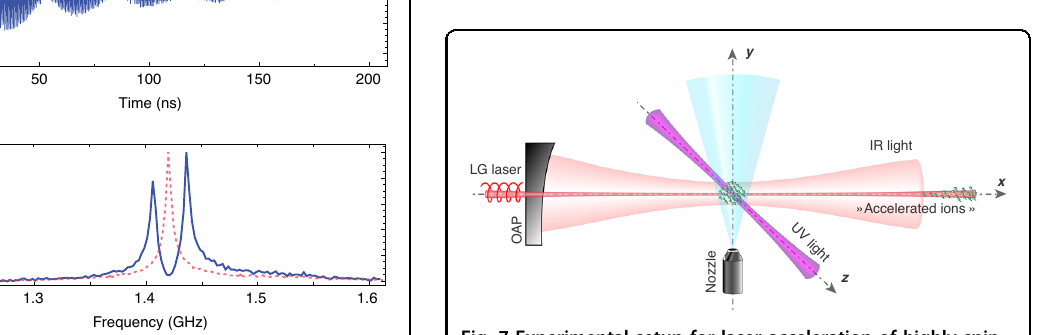
Fig. 7 Experimental setup for laser acceleration of highly spin- polarized protons, deuterons 52,53 , or electrons 10,51 . The nozzle produces an HY-molecule expansion in a vacuum chamber. An IR laser pulse aligns the HY bonds, and the circularly polarized UV laser photodissociates the HY molecules to produce SPH. The Y atoms can be removed by selective ionization with a UV laser. Finally, the spin- polarized protons, deuterons, or electrons from the SPH are ready for laser-driven wake fi eld acceleration by the high-power LG laser